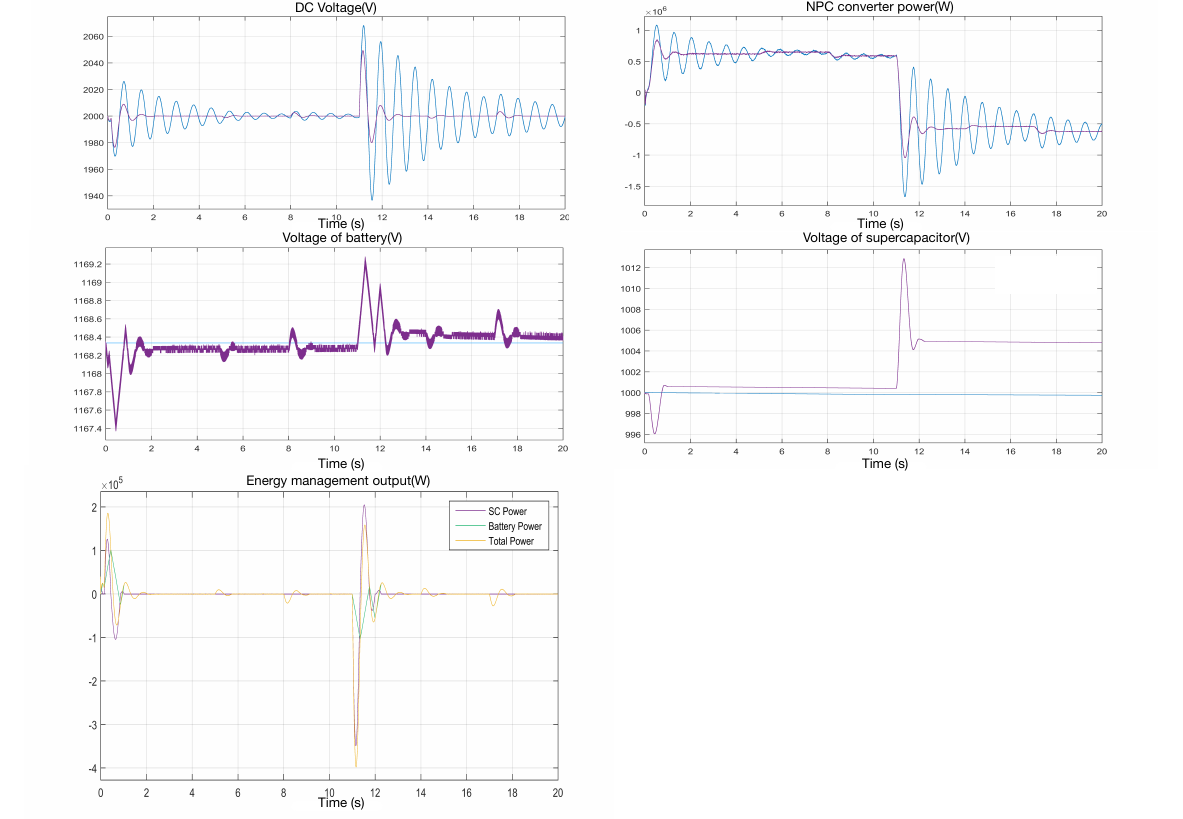
Figure 16. Simulation of cooperative